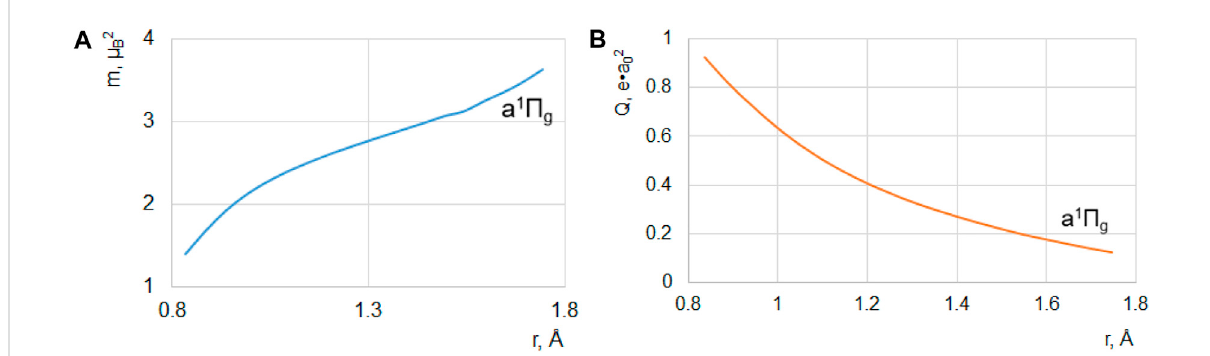
FIGURE 5 (A) Square of magnetic dipole moment m x 2 +m y 2 ( μ B is the Bohr magneton) and (B) electric quadrupole moment of the a 1 Π g – X 1 Σ g + transition in the N 2 molecule (both in a. u.).